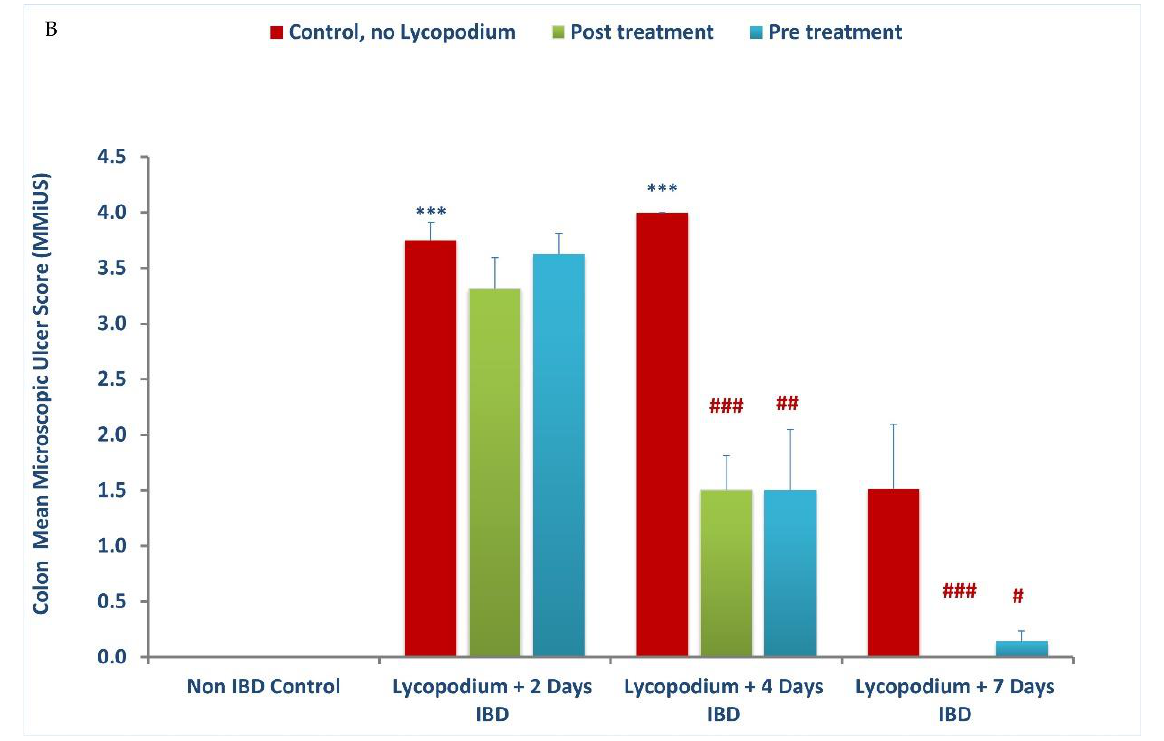
Figure 4. Effect of lycopodium on microscopic images in acetic acid-induced IBD in rats. ( A ): Naïve